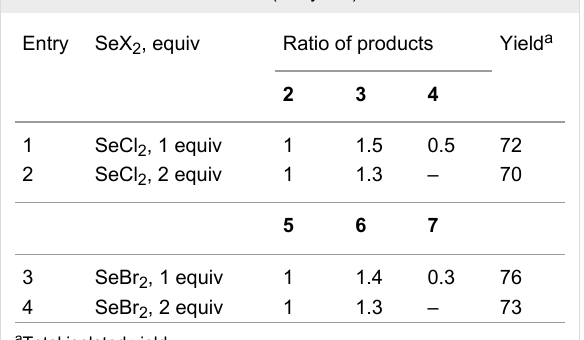
Table 1: Addition reactions to bis(acetylene) 1